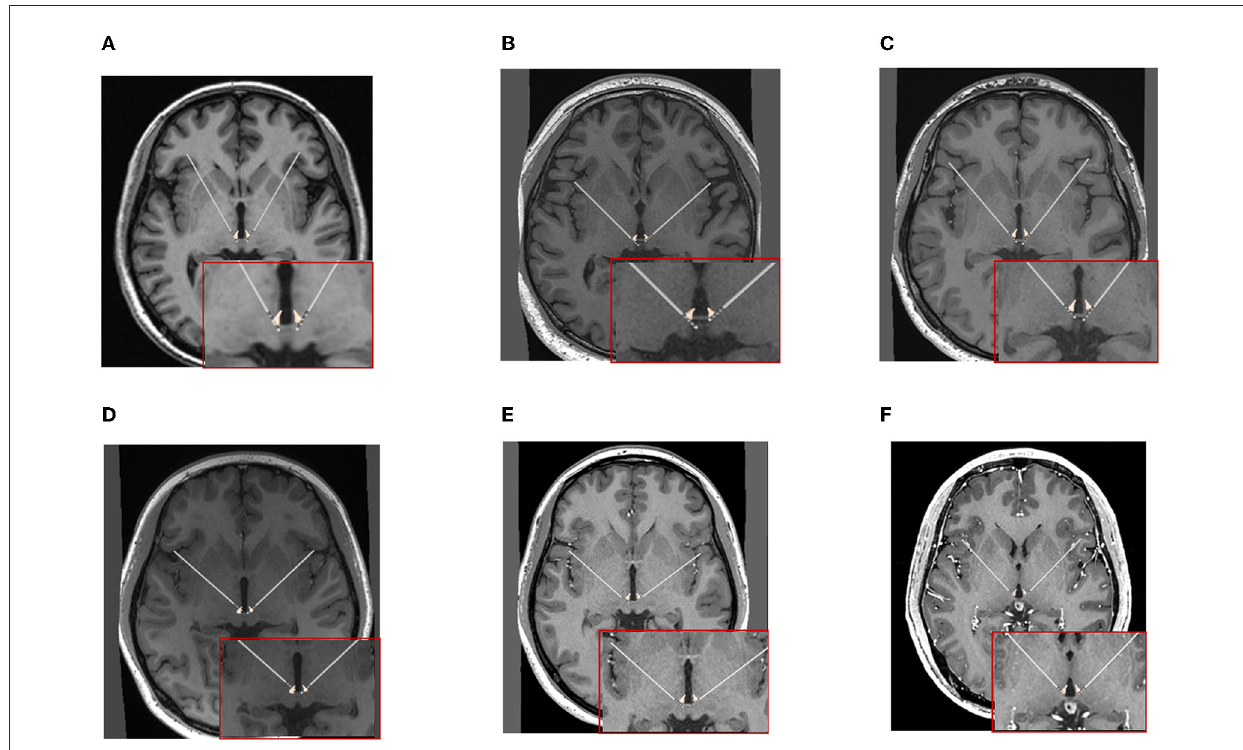
FIGURE4 The positions of DBS electrodes were reconstructed with the preoperative MRI and CT at 1 month after surgery for each patient. (A–F) Cases